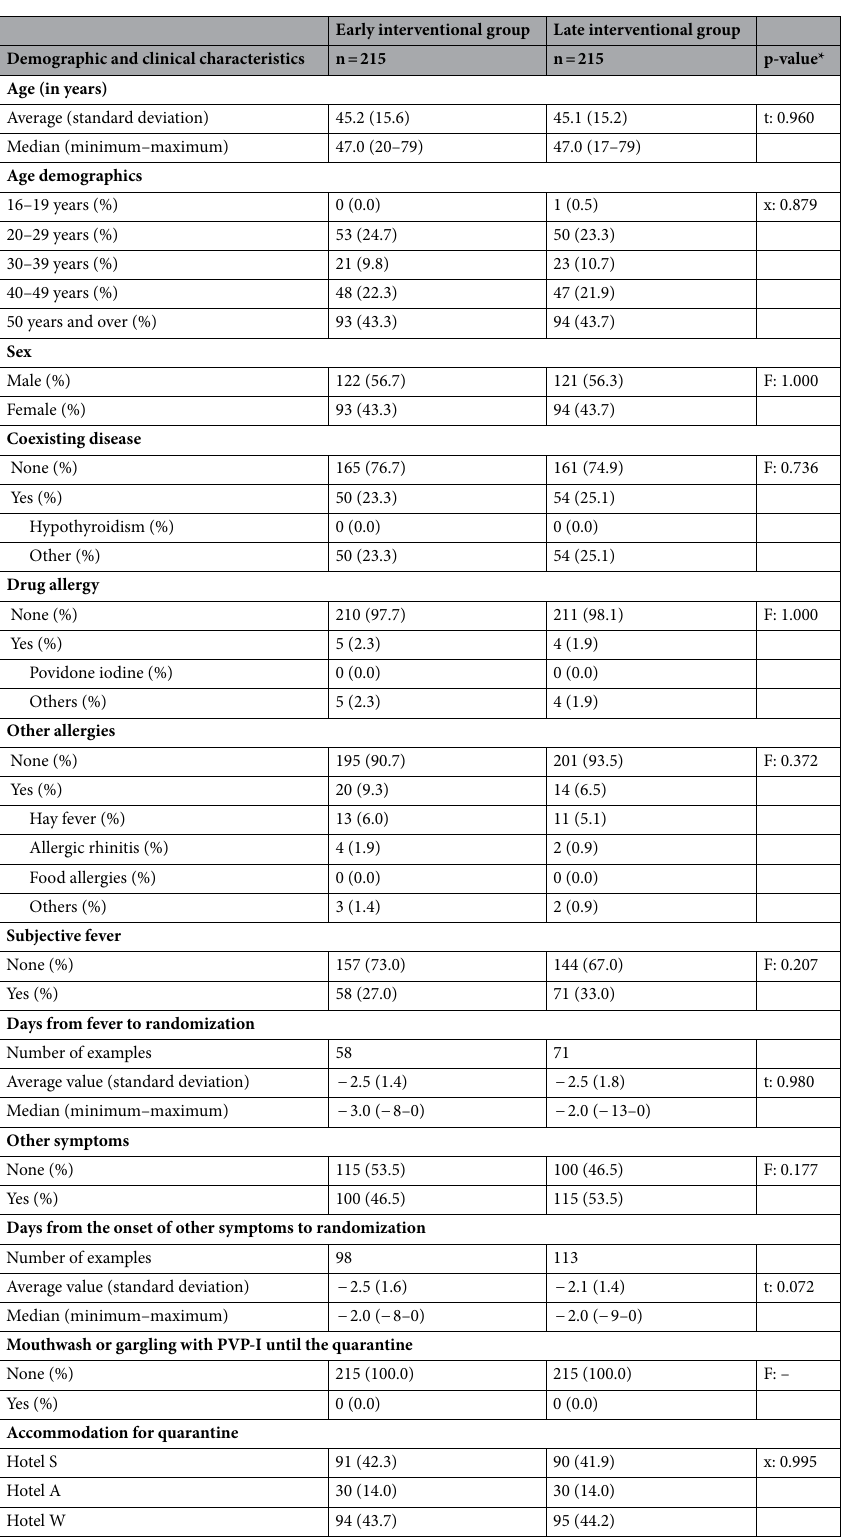
Table 2. Participants with COVID-19’s baseline demographics and clinical characteristics. *t: Student’s t-test, F: Fisher’s exact test, x: chi-square